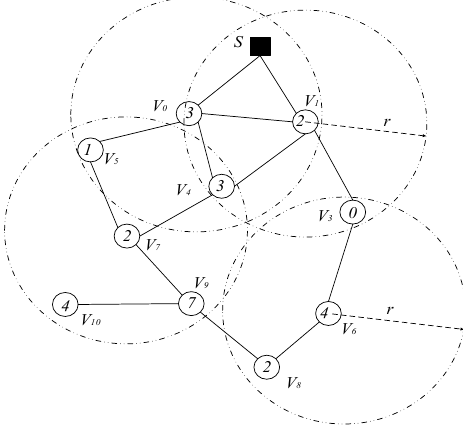
Figure 5. The codes dissemination in duty cycle based wireless sensor network.